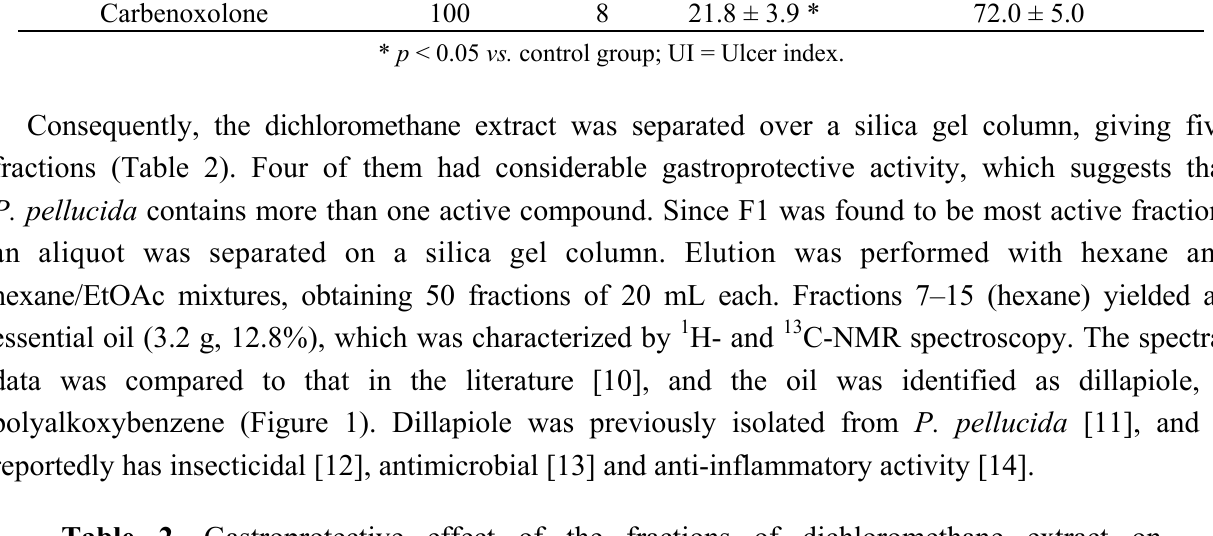
Table 2. Gastroprotective effect of the fractions of dichloromethane extract on ethanol-induced ulceration in